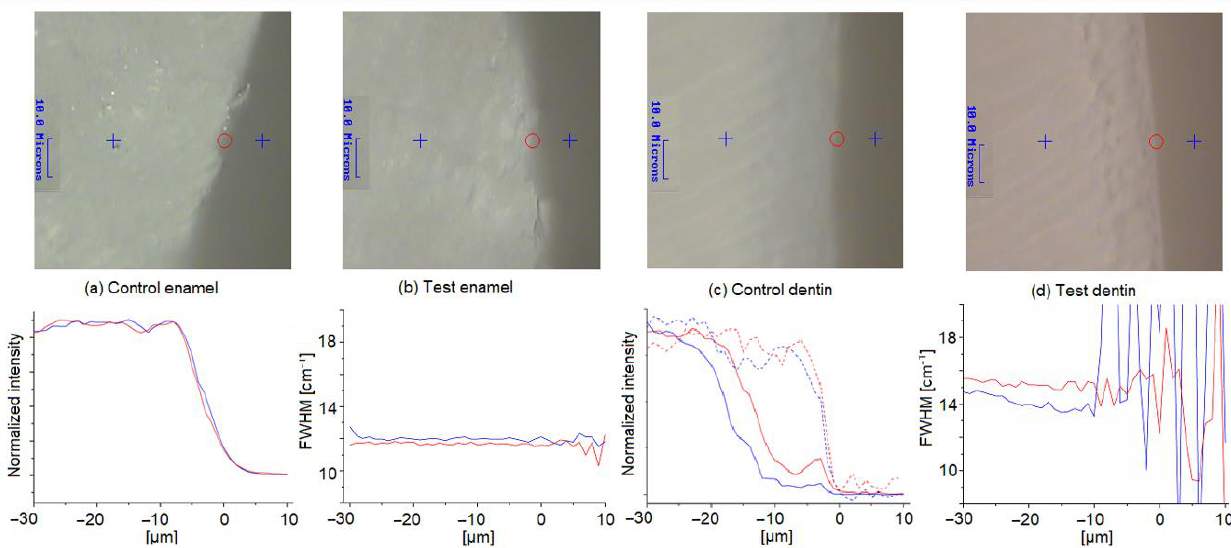
Figure 3. Micrographs of control and test samples with start, end, and reference points (upper row). Intensity of the hydroxyapatite band at 960 cm − 1 and full width at half maximum (FWHM) for control (blue, solids) and test (red, solids) samples: ( a ) Intensity of the hydroxyapatite band at 960 cm − 1 obtained from an enamel sample. ( b ) FWMH from enamel cross-sectional line profile. ( c ) Intensity of hydroxyapatite band at 960 cm −1 from dentin. Hydrocarbon band at 2900 cm −1 from the dentin control (blue, dashed) and dentin test sample (red, dashed). ( d ) FWHM from cross-sectional line profile obtained from dentin.